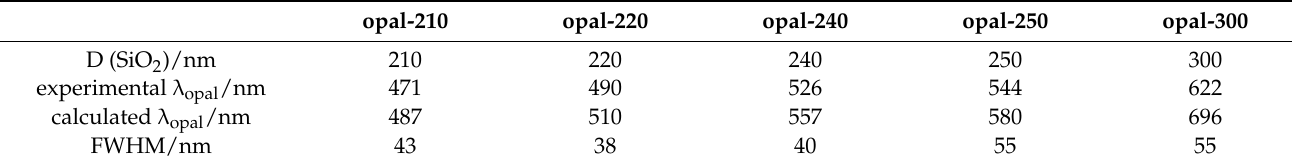
Table 1. Properties of silica opals with different silica sizes.